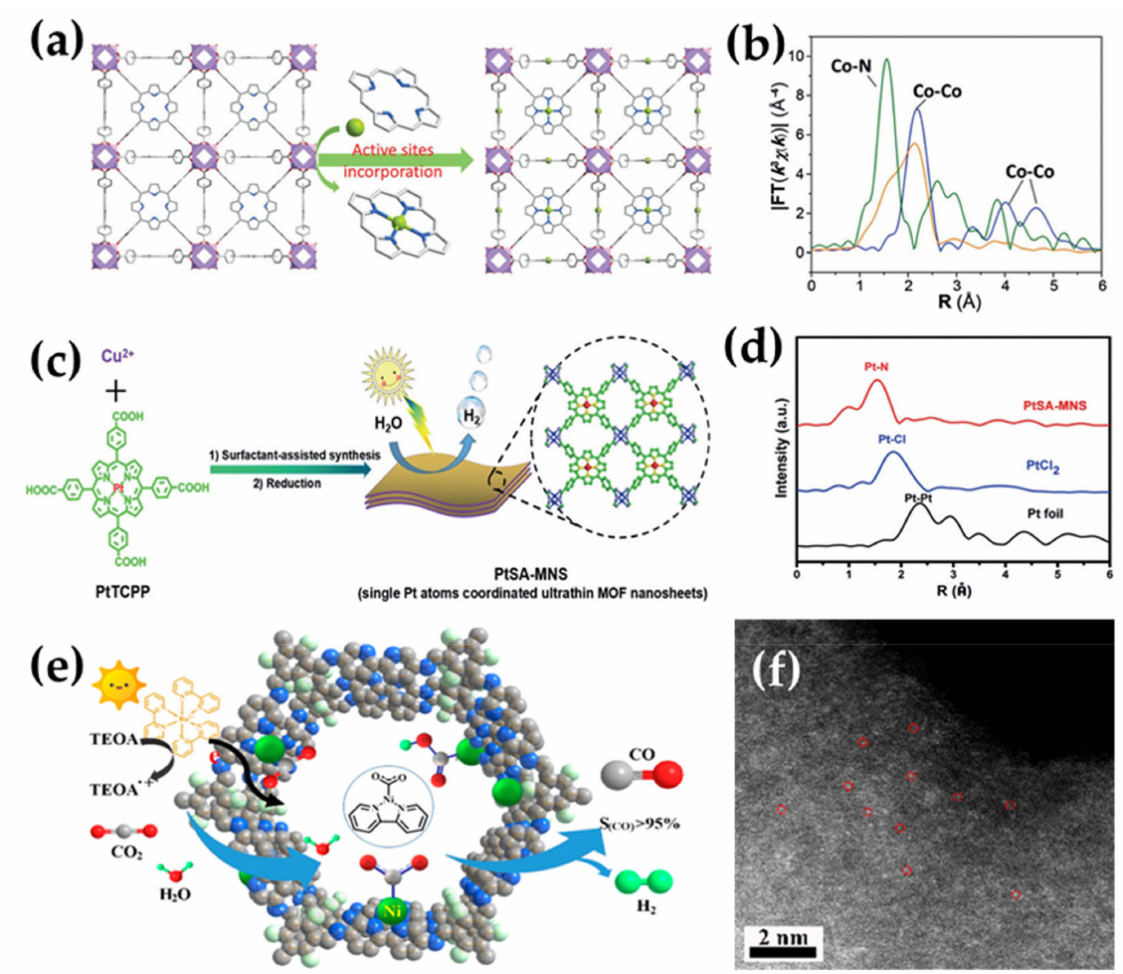
Figure 4. ( a ) View of the 3D network of MOF-525-Co featuring a highly porous framework and incorporated active sites [65]; ( b ) Fourier transform magnitudes of the experimental Co K-edge EXAFS spectra of samples (not corrected for phase shift). Key: Co foil (blue), Co@C (orange), MOF-525-Co (green) [65]; ( c ) Illustration of the synthetic route towards Pt single-atom coordinated ultrathin MOF nanosheets (PtSA-MNSs) through a surfactant-stabilized coordination strategy for photocatalytic hydrogen production [66]; ( d ) Pt L 3 -edge EXAFS spectra for PtSA-MNSs, PtCl 2 , and Pt foil [66]; ( e ) Schematic diagram of photocatalytic selective reduction of CO 2 over Ni-TpBpy [69]; ( f ) aberration-corrected HAADF-STEM image of Ni-TpBpy